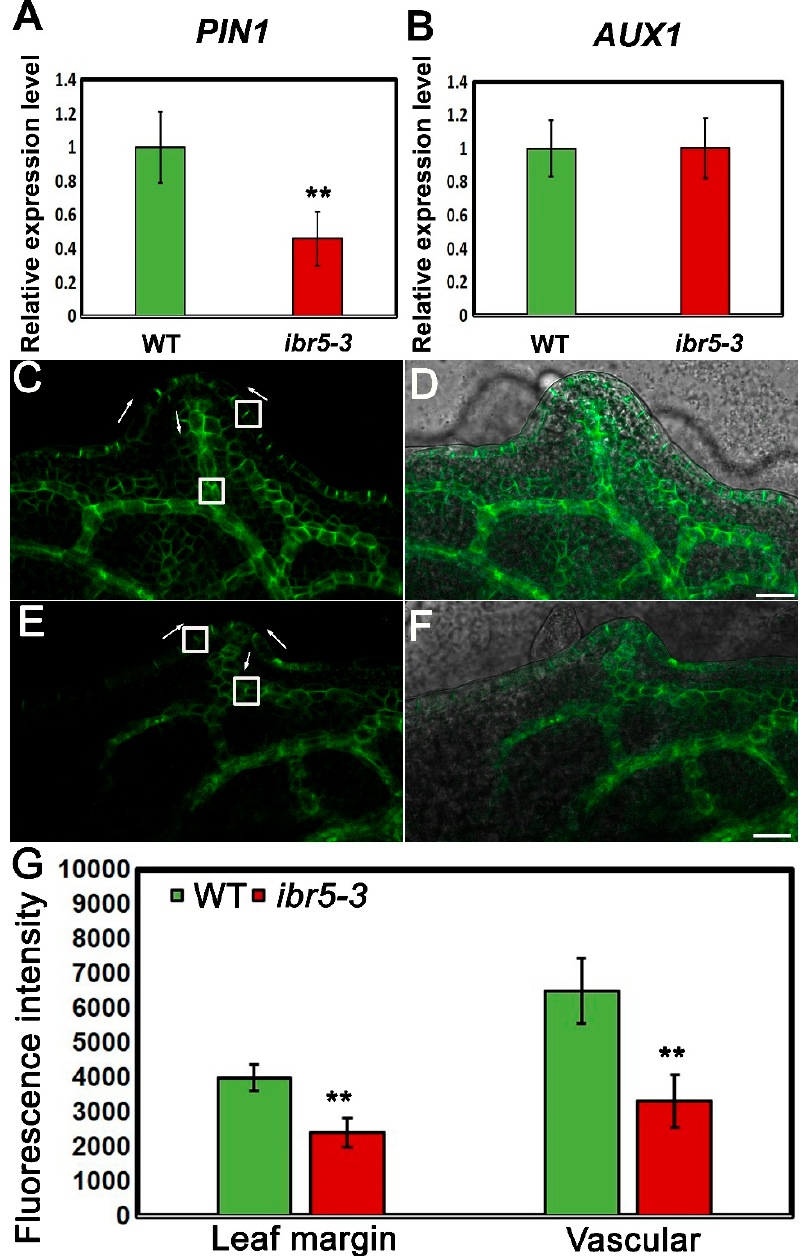
Figure 5. The distribution of PIN1 in the leaf serrations of WT and ibr5-3 . ( A ) The relative expression level of PIN1 in WT and ibr5-3 . Error bars are ± SE, n = 3 independent replicates and each with 3 biological replicates analyzed in each assay. ( B ) The relative expression level of AUX1 in WT and ibr5-3 . Error bars are ± SE, n = 3 independent replicates and each with 3 biological replicates analyzed in each assay. ( C , D ) The representative image of PIN1-GFP in the 10-day-old leaf serrations of WT. Bar, 20 µ m. The white boxed regions were used for analysis. The white arrows indicate the direction of auxin transport. ( E , F ) The representative image of PIN1-GFP in the 10-day-old leaf serrations of ibr5-3 . Bar, 20 µ m. The white boxed regions were used for analysis. The white arrows indicate the direction of auxin transport. ( G ) The quantified analysis of the fluorescence intensity of PIN1-GFP in 10-day-old leaf serrations in WT and ibr5-3 . Error bars are ± SE, n = 3 independent replicates and each with 12 leaves analyzed in each assay. Two asterisks mean significant differences ( p < 0.01 from Student’s t -test).